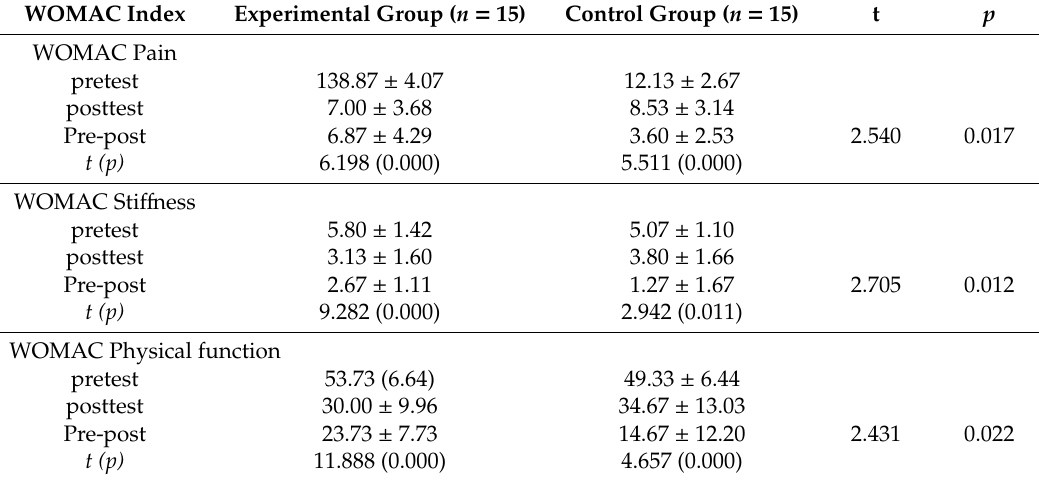
Table 4. Comparison of the Western Ontario and McMaster universities osteoarthritis index (WOMAC) scores ( n = 30).